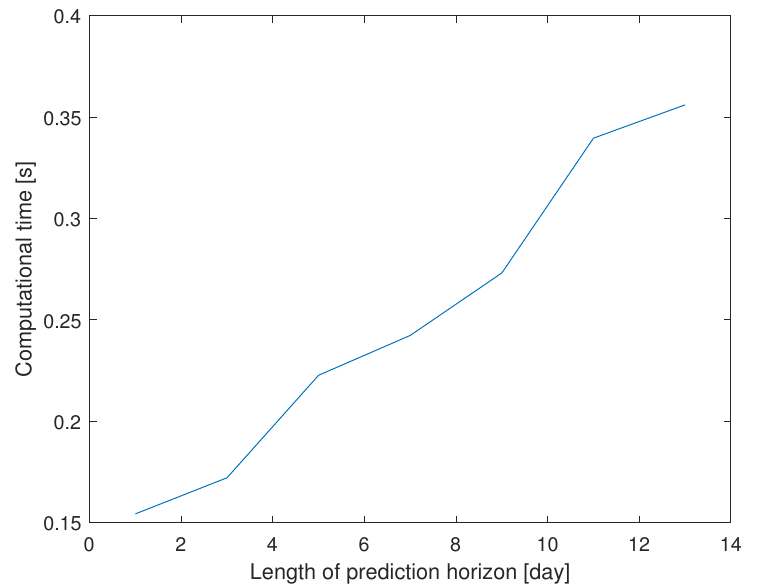
Figure 8. Average computational time taken depending on the length of the prediction horizon when the test set 3 is